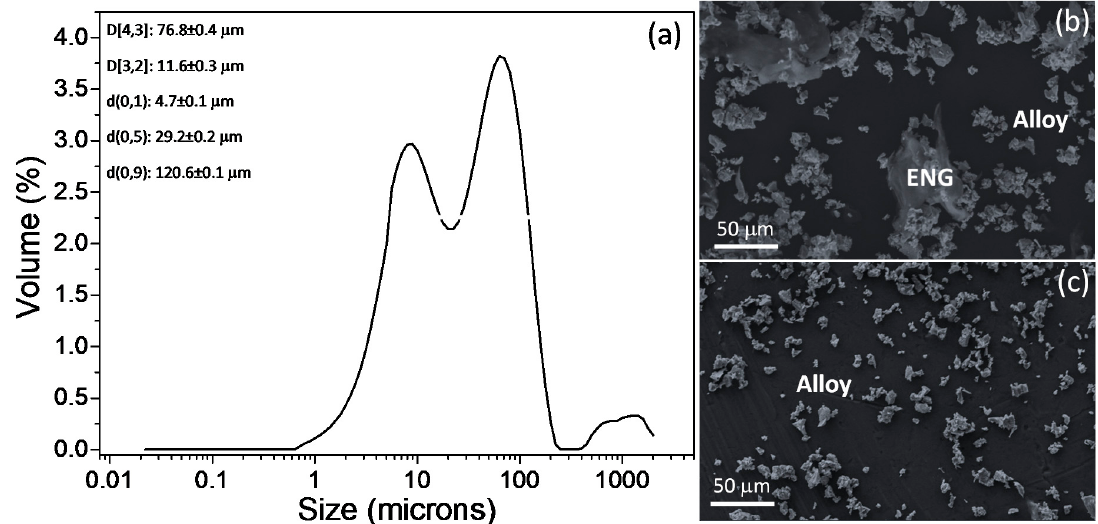
Figure 5. ( a ) PSD analysis and SEM photo for the ( b ) (Ti 0.9 Zr 0.1 ) 1.25 Cr 0.85 Mn 1.1 Mo 0.05 + 10 wt.% ENG and ( c ) (Ti 0.9 Zr 0.1 ) 1.25 Cr 0.85 Mn 1.1 Mo 0.05 alloy in powder form after hydrogen cycling. The cycling stability of hydrogen capacity for the (Ti 0.9 Zr 0.1 ) 1.25 Cr 0.85 Mn 1.1 Mo 0.05 + 10 wt.% ENG